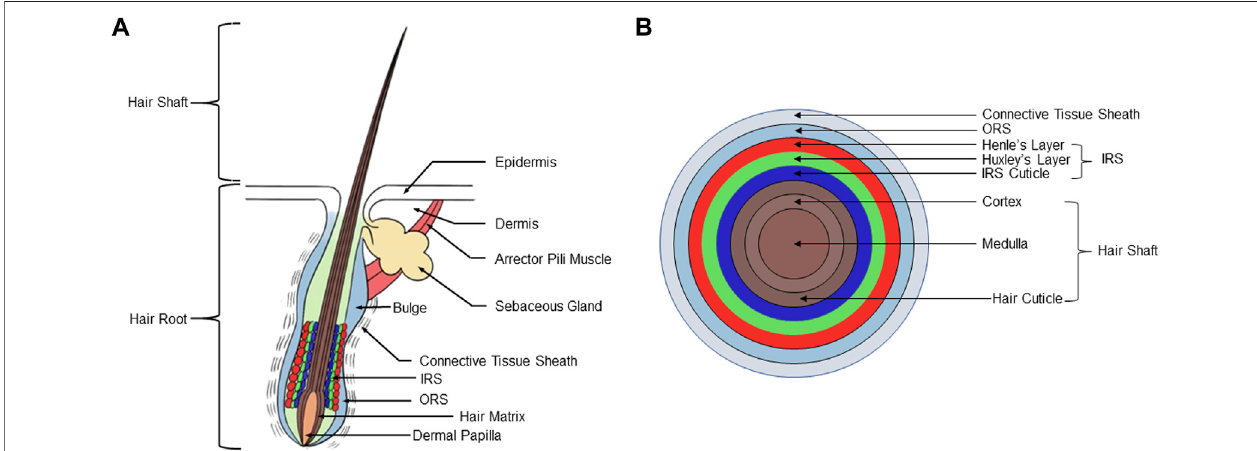
FIGURE 1 | Structure of hair follicle. (A) A human scalp hair follicle (anagen VI): the permanent (infundibulum, isthmus) and anagen associated (suprabulbar and bulbar area) components of the hair follicle. (B) Schematic diagram of the concentric layers of the hair follicle bulb, including hair shaft, IRS, outer root sheath, and connective tissue sheath. IRS, inner root